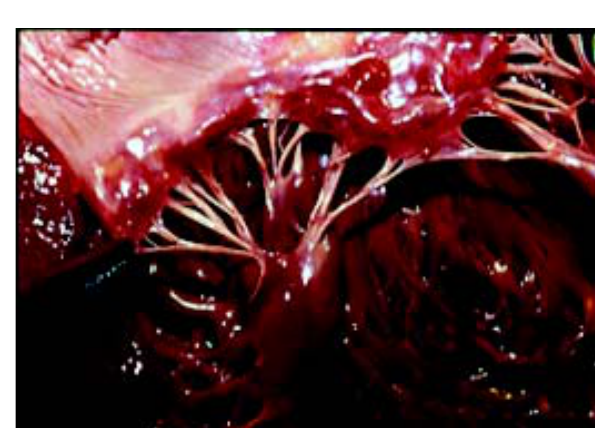
Fig. 1 - Anatomia do músculo papilar. As três cabeças podem ser